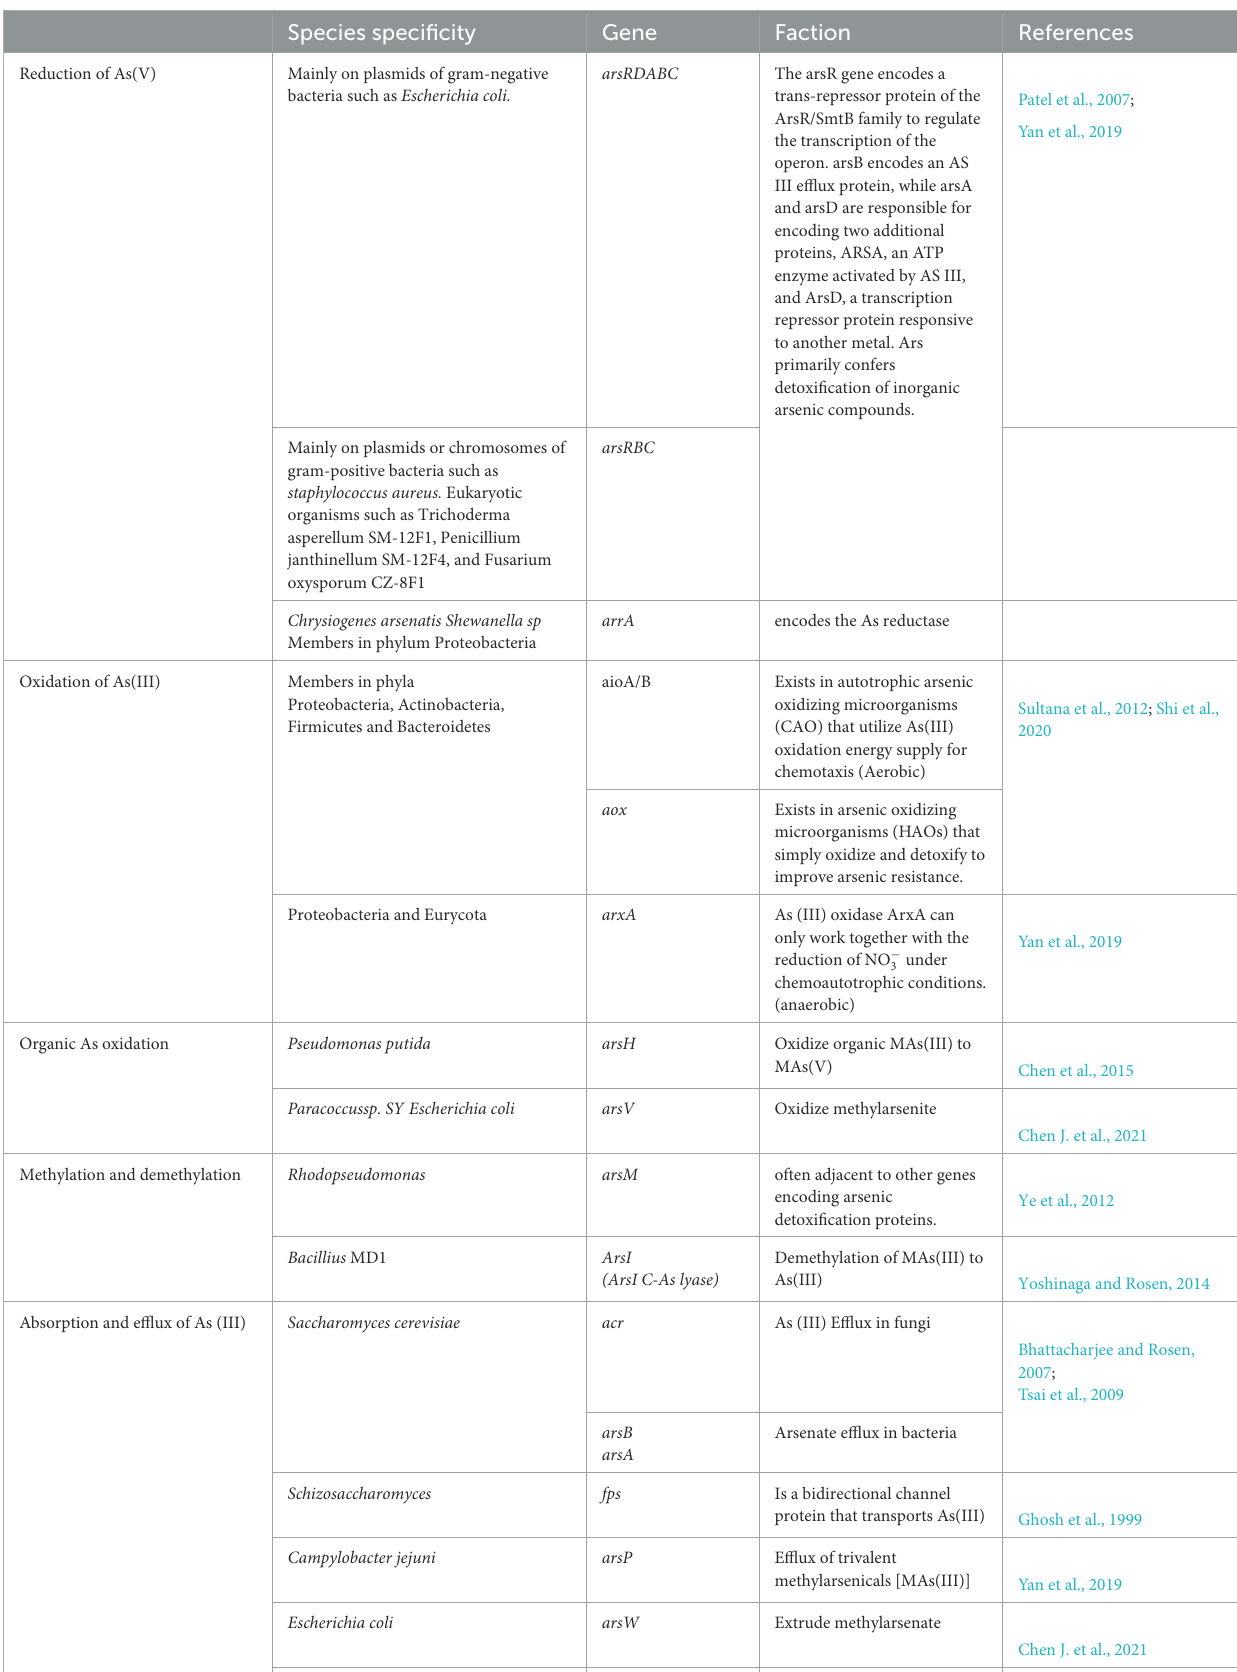
TABLE 1 Major genes involved in arsenic